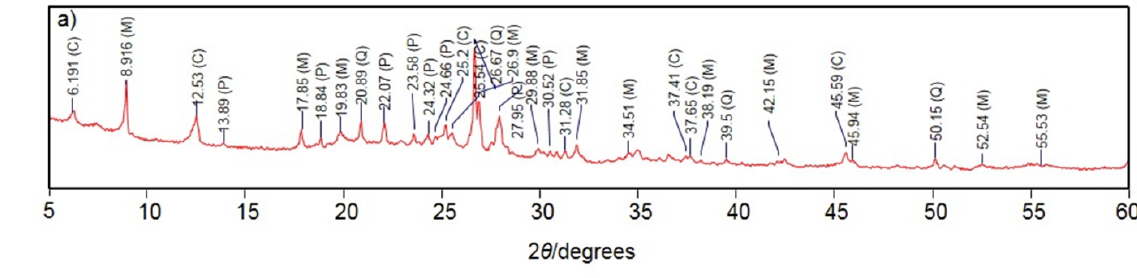
Figure 2: XRPD analysis of raw trepel (Q: quartz, M: muscovite, C: chlorite, P: plagioclase).